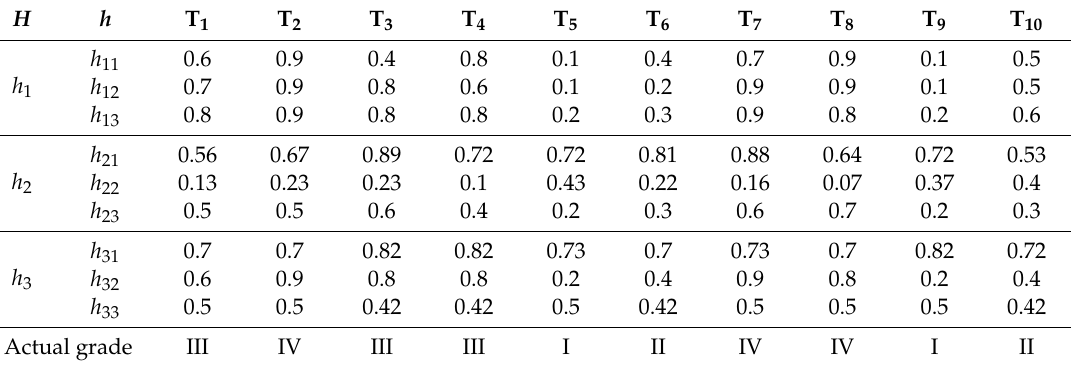
Table 7. Stability grades for slopes in group